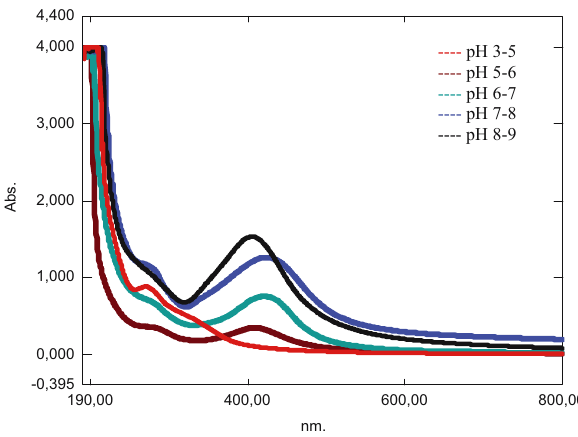
Figure 6: UV - spectra showing the e ff ect of pH on the deformation of the synthesized AgNPs of T. govanianum